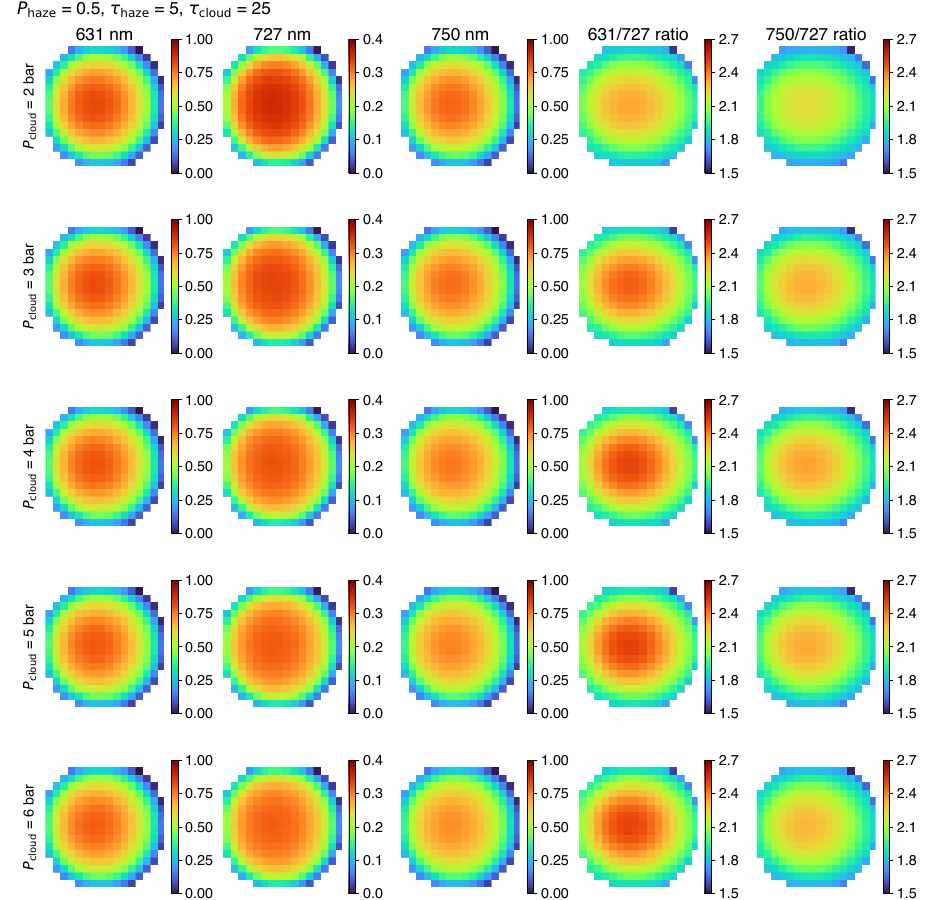
Figure 11. Reflectivity values (left columns) and CM7 reflectivity ratios (right columns) calculated over the coarse geometrical grid defined in Figure 10. Each row is for a different deep cloud pressure level, and all calculations are for the case of τ haze = 5 and τ cloud = 25. Overall reflectivity and limb darkening are weaker for the 727-nm filter compared to the continuum filters, because the relative contribution from upper-tropospheric haze (lying above much of the methane absorption) is greater compared to the contribution from the tropospheric cloud decks at the stated pressure levels. CM7 ratios increase with cloud depth in most